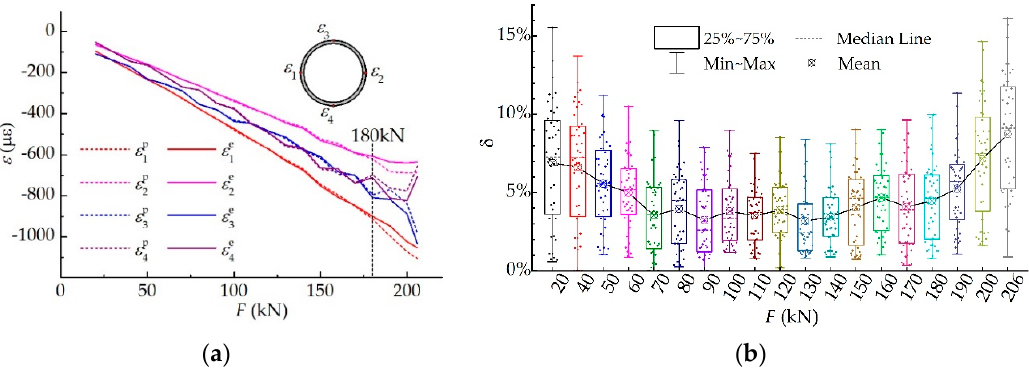
Figure 4. The error results of strain data in arch-A: ( a ) Contrast curves on cross-section 4; ( b ) the validation errors of all sections.